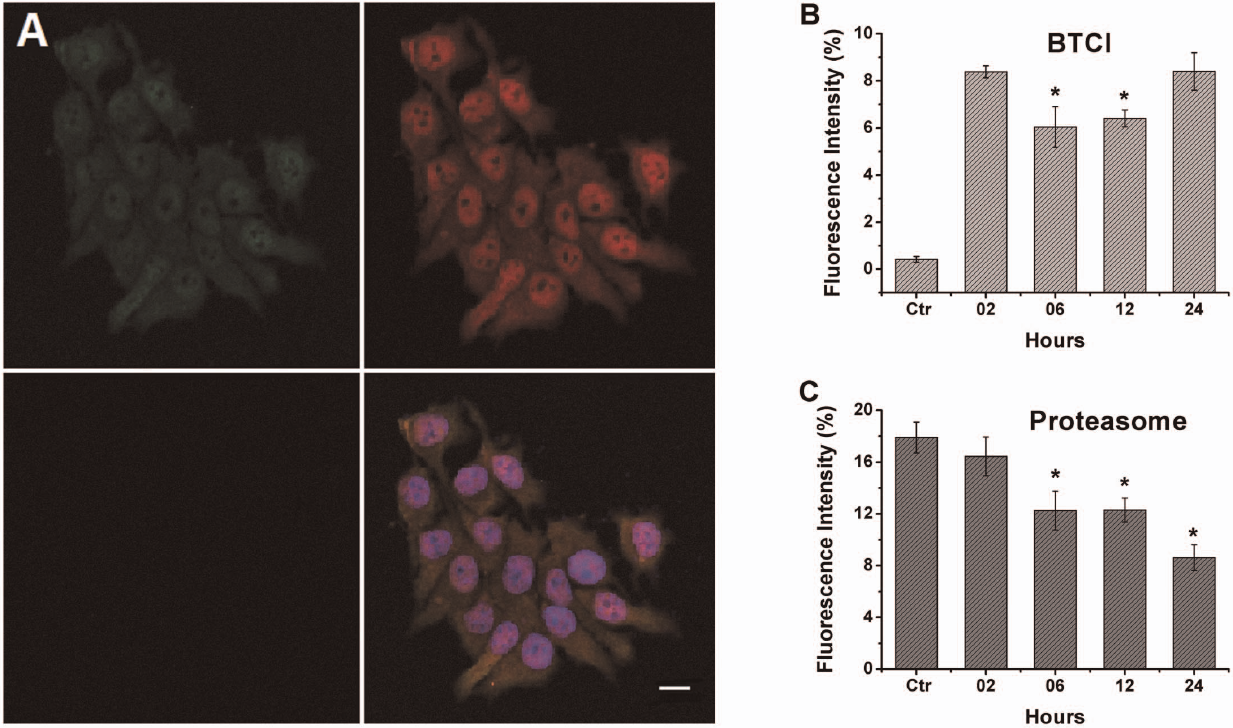
Figure 3. Immunofluorescence of the proteasome and BTCI in the MCF-7 cells by Confocal Microscopy. A) BTCI (green), proteasome (red), and BTCI proteasome colocalization (yellow) with DAPI DNA marked in blue. The anti BTCI specificity was assessed in MCF-7 cells treated with 200 m M BTCI for 2, 6, 12 and 24 hours, whereas the control was done without BTCI (black). Fluorescence intensity of BTCI (B) and the proteasome (C) was calculated by ImageJ program as a function of the incubation time of BTCI in MCF-7 cells. Ctr: control; T-test: *p , 0.001, compared to 2 hours of BTCI incubation. Bar=20 m m.